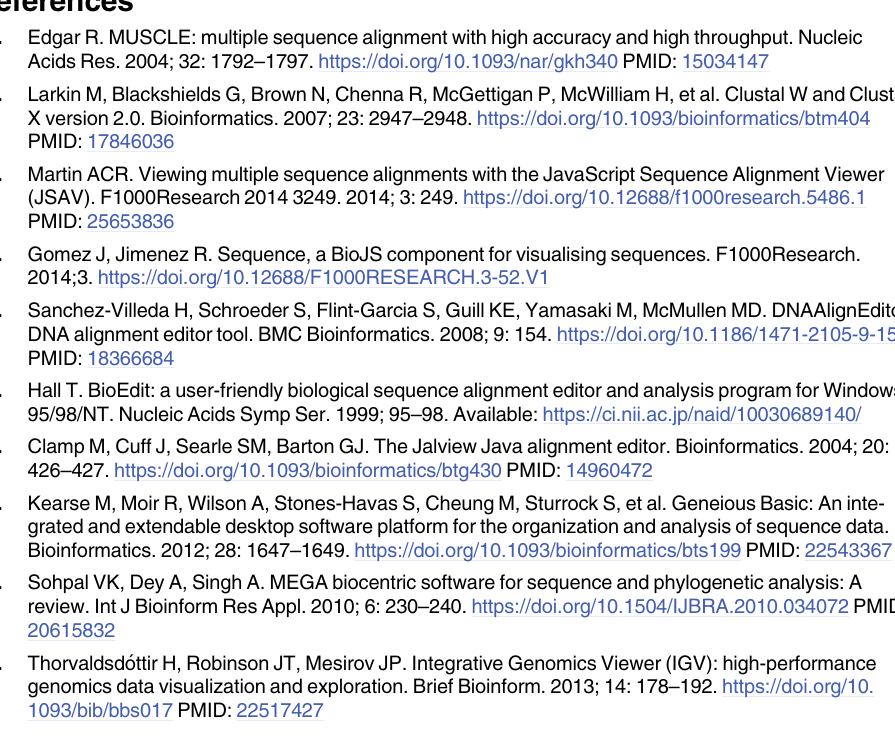
S1 Table. Nucleotide frequencies from the V3 loop. Sites covering codon 11 and 26 are highlighted in